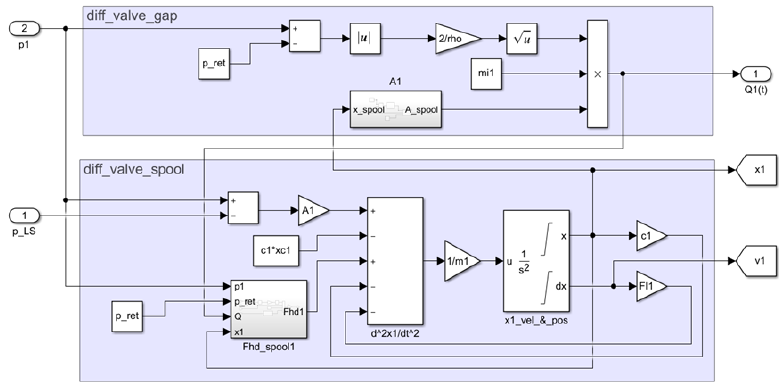
Figure 5. Differential valve subsystem in Simulink.